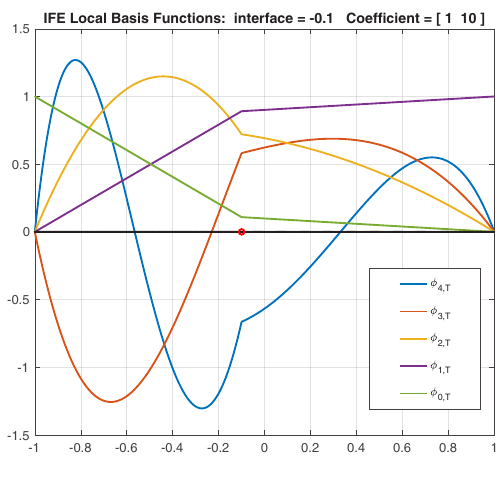
Figure 1. IFE local basis functions on the element (